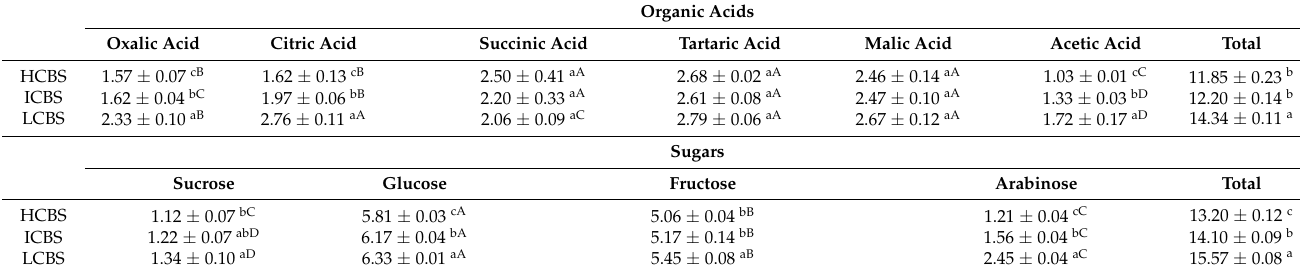
Table 2. Effect of particle size on organic acids and sugars contents of cocoa bean shell flours. Organic Acids